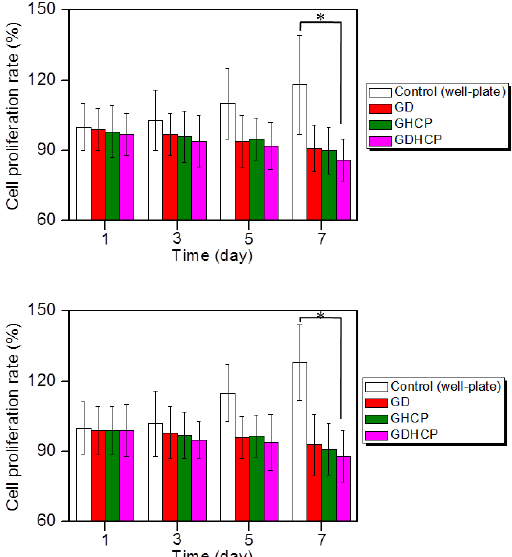
Figure 3. Proliferation rates of (top) MG-63 and (down) KHOS/NP cells cultured with control, GD, GHCP and GDHCP (DOX·HCl: 2 mg/kg and CP: 2 mg/kg against each hydrogel) at 37 °C for 1, 3, 5